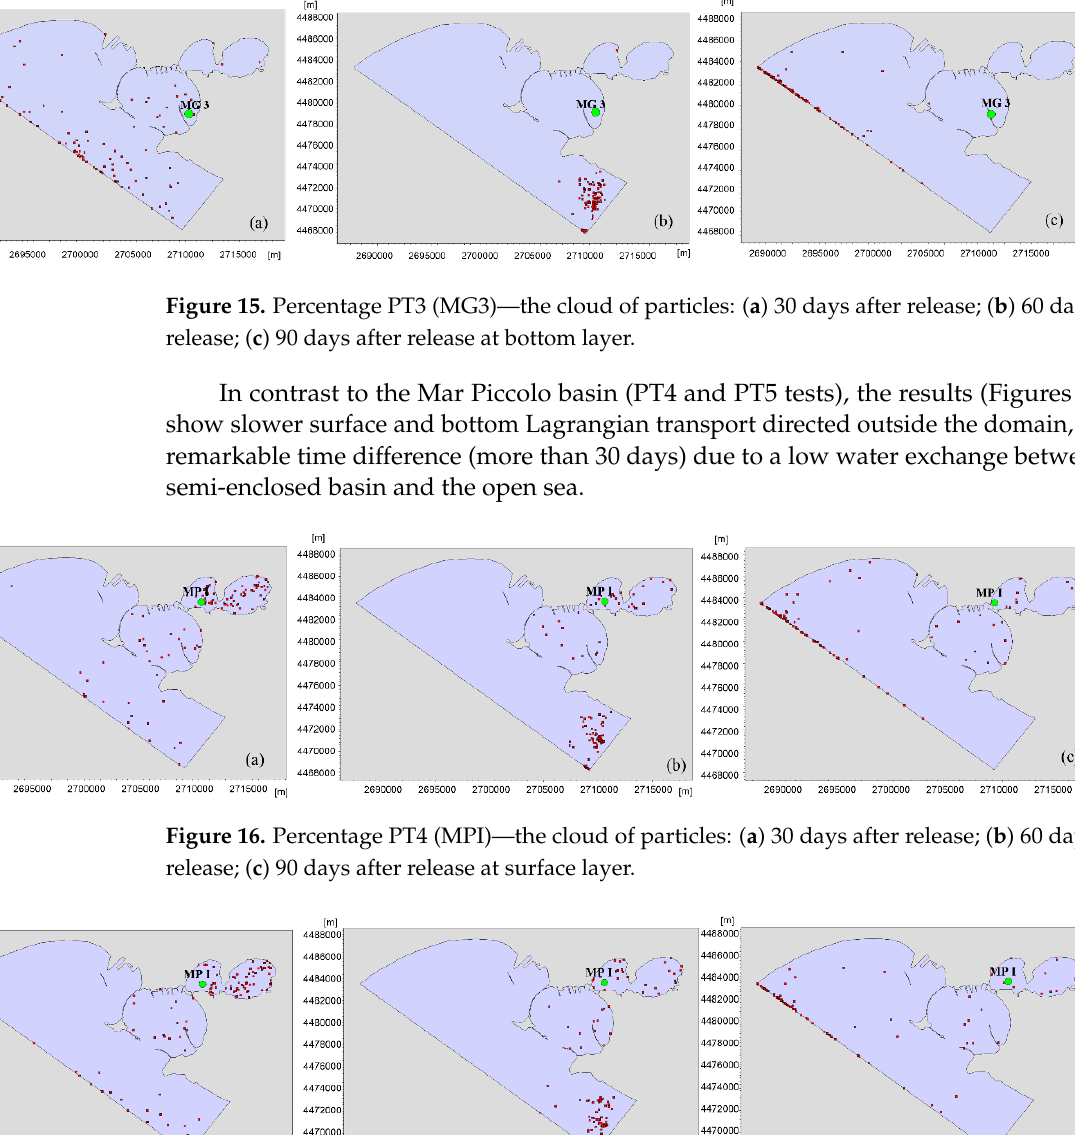
Figure 17. Percentage PT4 (MPI) — the cloud of particles: ( a ) 30 days after release; ( b ) 60 days after release; ( c ) 90 days after release at bottom layer.